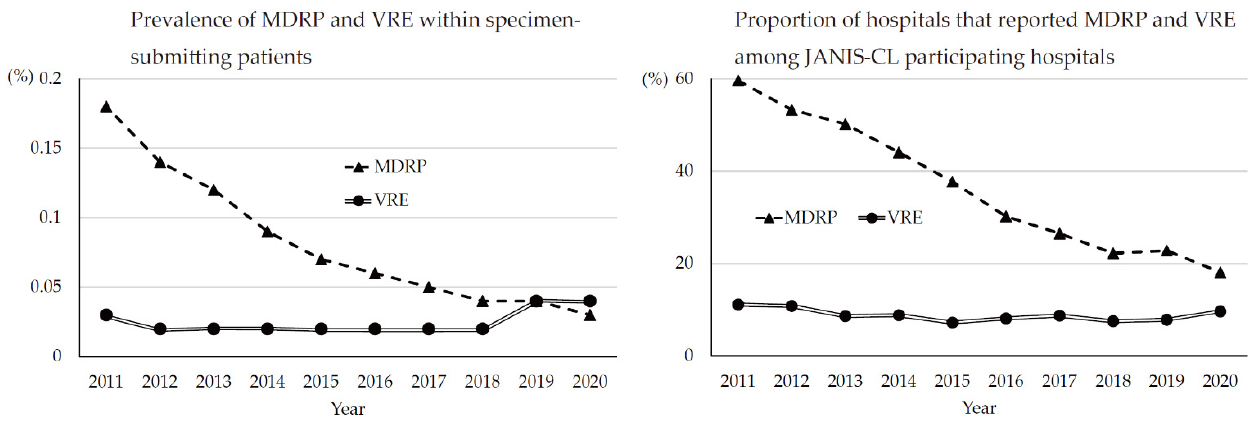
Figure 4. Trends of MDRP and VRE in JANIS-CL, 2011 to 2020.